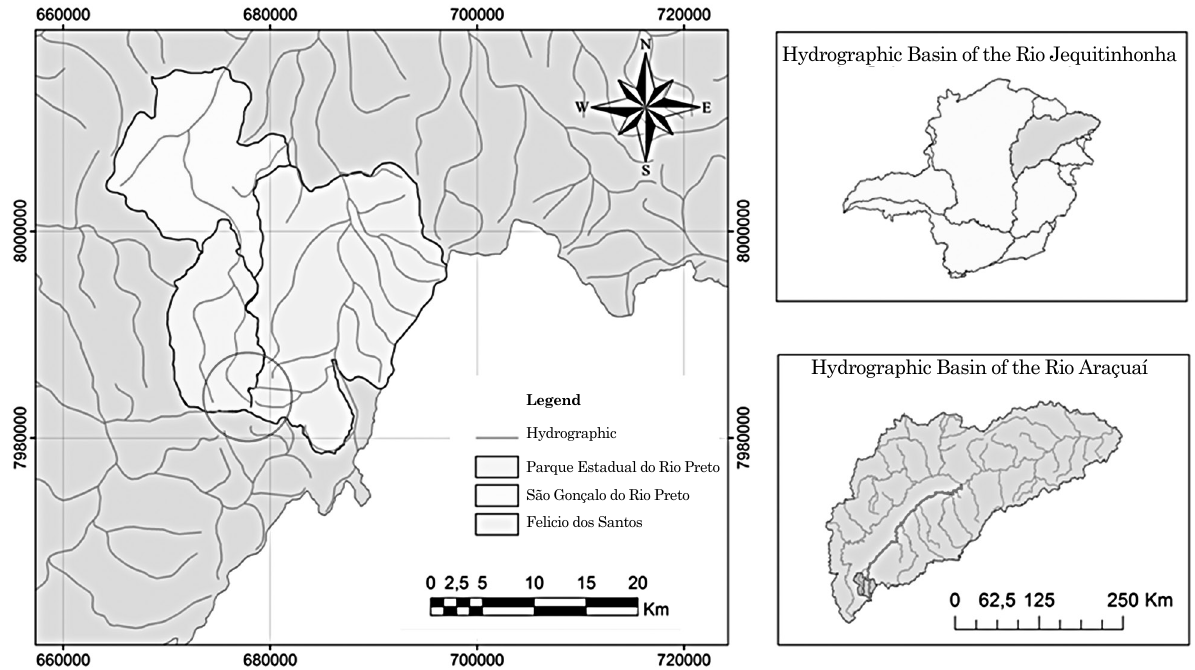
Figure 1. Collection area of the core samples in the tributaries of the headwaters of the Rio